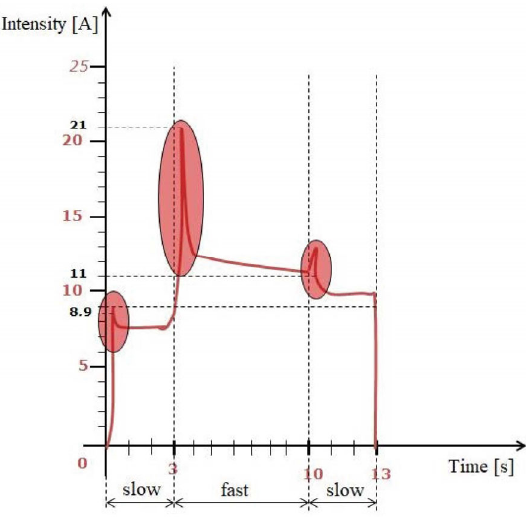
Figure 8. Engine intensity measured over time.